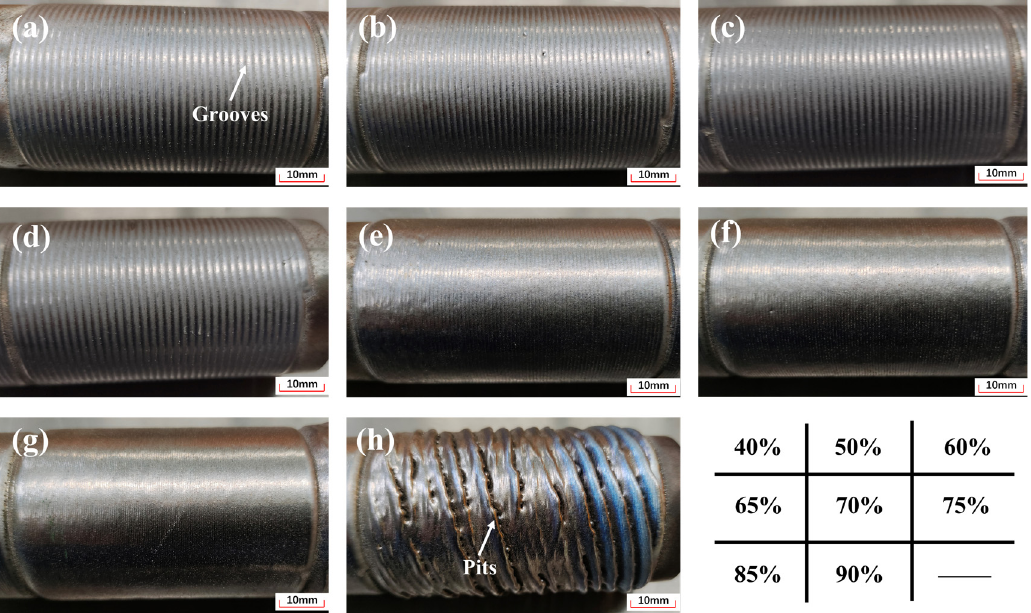
Figure 20. Macro-morphologies of EHLA coatings under different overlapping ratios. ( a ) 40%; ( b ) 50%; ( c ) 60%; ( d ) 65%; ( e ) 70%; ( f ) 75%; ( g ) 85%; ( h ) 90%.